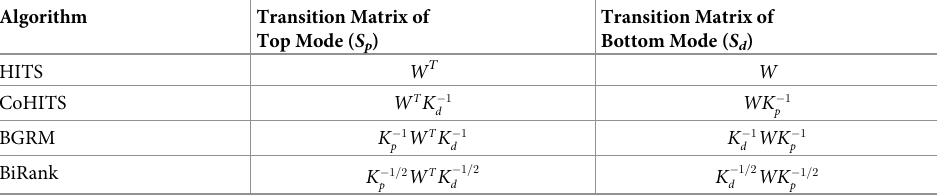
K d and K p represent diagonal matrices with the generalized degrees (sum of edge weights) on the diagonal of each mode of the network. Specifically, ( K d ) ii = ∑ i w ij and ( K p ) jj = ∑ i w ji